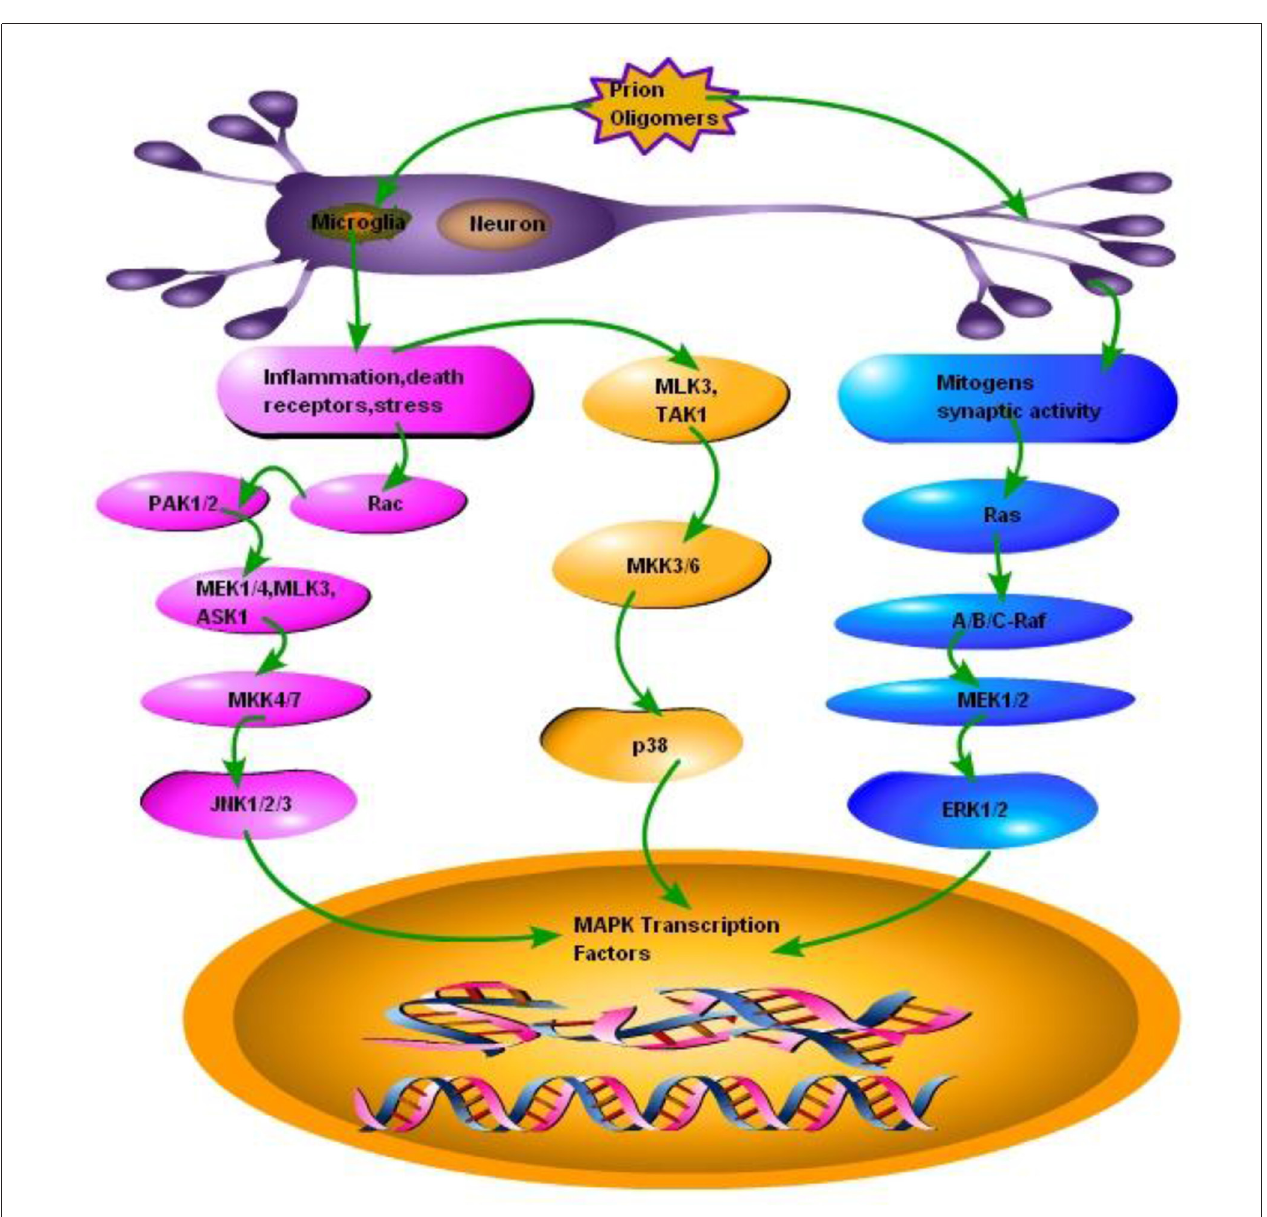
FIGURE 2 | Schematic presentation of a single neuron affected by the prion fibrils and oligomers. Accumulation of misfolded PrP Sc results in the activation of microglia and subsequently activating two types of responses: (1) Inflammation, stress and death receptors response; This response activates two pathways, one branch activates mixed-lineage protein kinase 3 (MLK3) and transforming growth factor activated kinase-1(TAK1), MLK3 and TAK1 activates mitogen-activated protein kinase kinase 3, 6 (MKK3, 6) MKK3, 6 activates the p38 branch of MAPK pathways, while the other branch of Inflammation, stress and death receptors response activates GTP binding protein (RAC), RAC activates P21 protein (Cdc42/Rac)-Activated Kinase 1 and 2 (PAK1, 2), PAK1, 2 activates mitogen activated protein kinase 1 and 4, MLK3 and apoptosis signal-regulating kinase 1 (ASK1), MEK1/4, MLK3 and ASK1 activates MKK4/7 to ultimately activate JNK branch of MAPK pathway. (2) Mitogens synaptic activity response; this branch activates small GTP binding proteins (Ras), Ras activates serine/theronine protein kinase (Raf A, B and C), Raf-A, B and C activates MEK1/2, which activates third branch of MAPK pathway